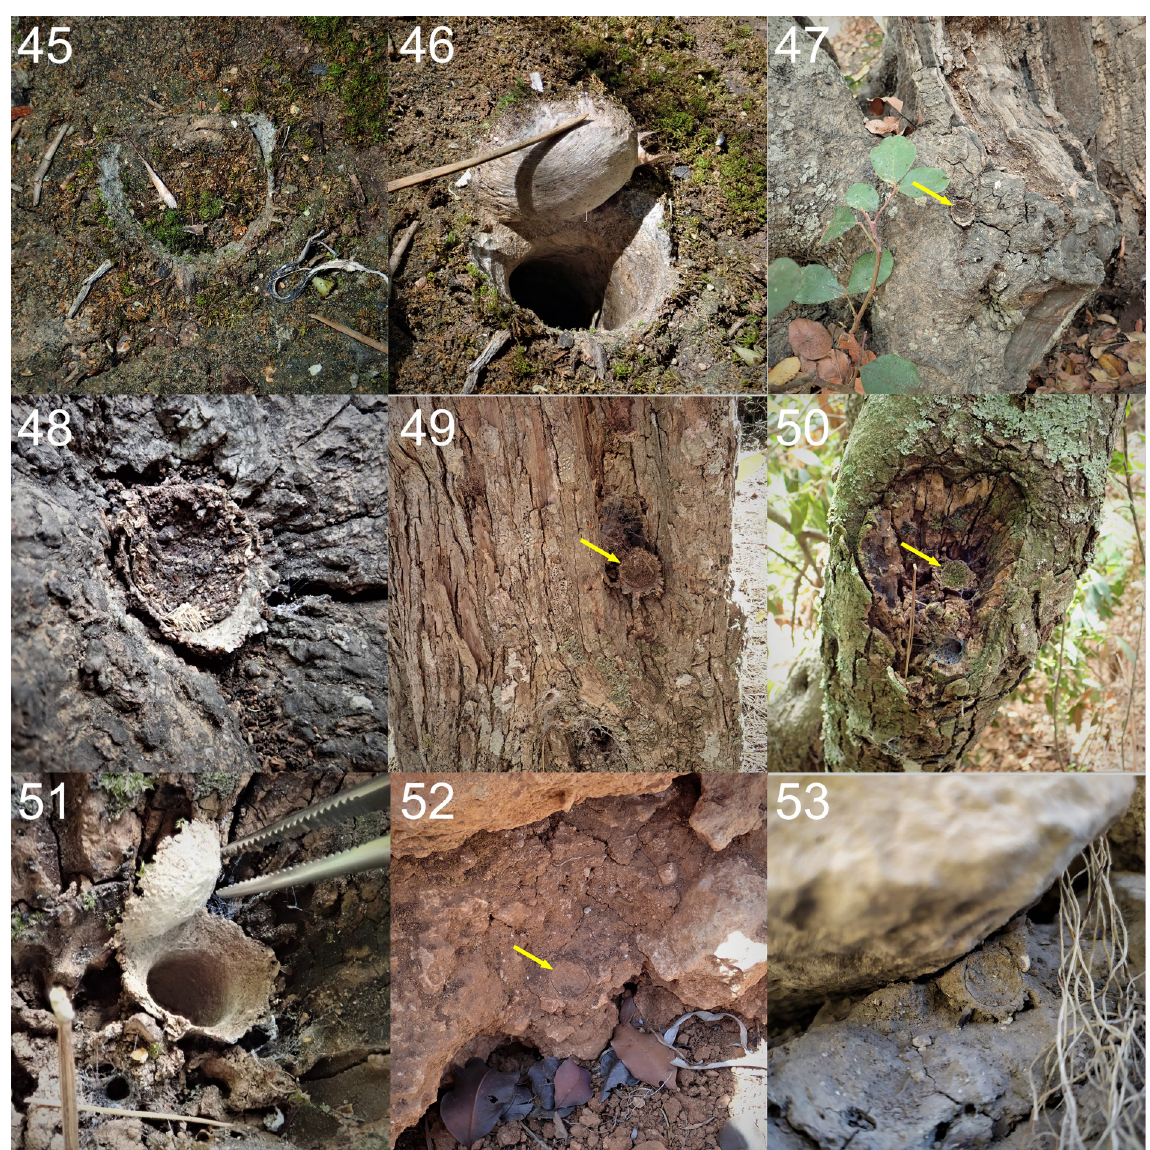
Figs 45–53. Nemesia arboricola Pocock, 1903 excavates its burrows in various natural settings such as crevices between rocks and roots and pre-existing, soil filled cavities in rocks and tree trunks. 45 . Circular outline of a trapdoor in open, moss-covered soil. 46 . Same trapdoor opened to show its thick, plug-like structure that snugly fits into the borrow entrance opening. 47 . Trapdoor capping a burrow excavated in a soil filled hole near the base of a carob tree. 48 . The same trapdoor (47) in close- up. 49 . Trapdoor capping a burrow excavated in a soil filled hole in an olive tree. 50 . Trapdoor capping a burrow excavated in a soil filled hole in an unidentified tree. 51 . The same trapdoor (50) in close-up and opened. 52 . Circular outline of a trapdoor in dry soil at the bottom of a rubble wall. 53 . Exposed top of a burrow and trapdoor in soil between rocks of a rubble